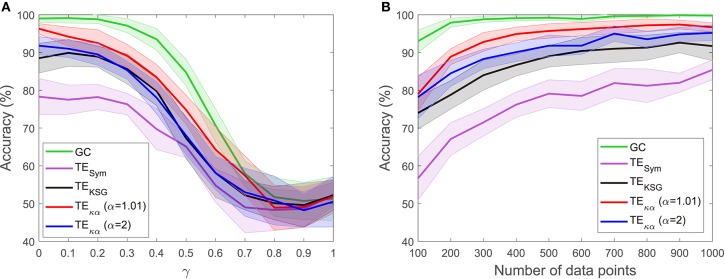
Accuracies in the detection of the preferred direction of information flow for synthetic data generated from a unidirectional bivariate autoregressive model of order 3: (A) for varying symmetric noise levels (as a function of the parameter γ), (B) for a varying number of data points.